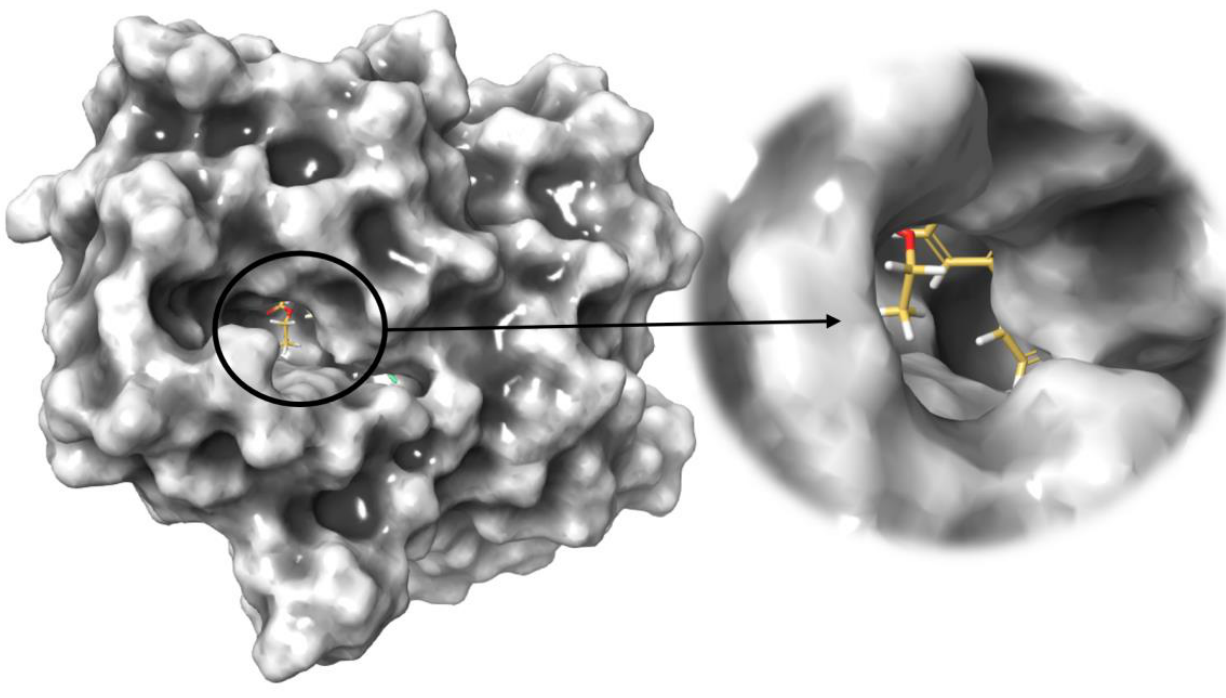
Figure 6. 3D surface view of the PPAR- γ and 4d ligand complex.